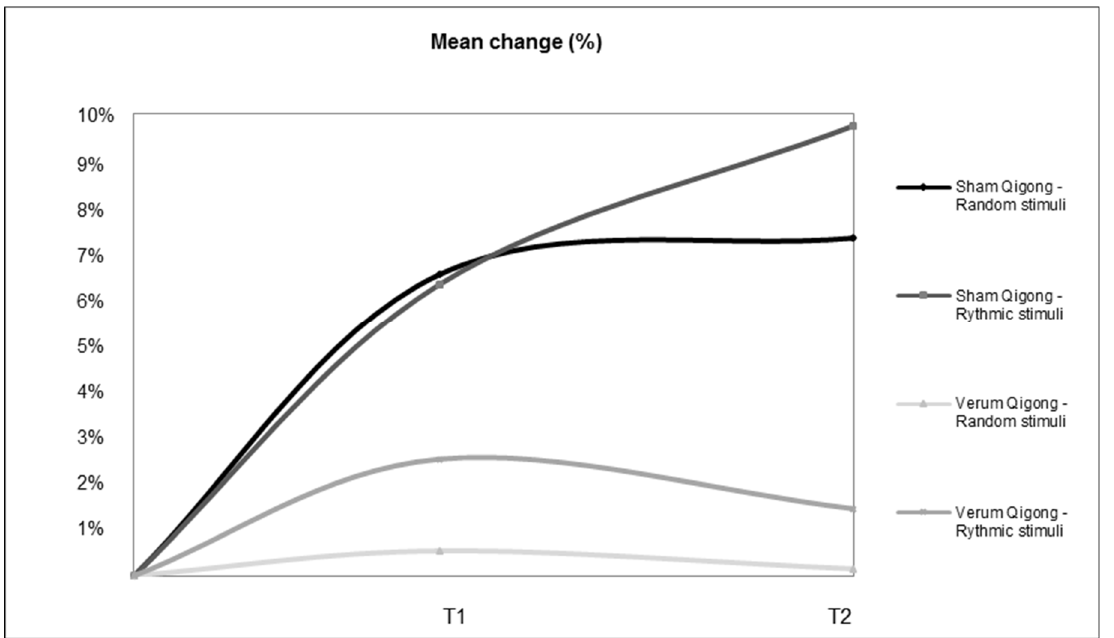
Figure 2. Mean percentage change in reaction time for both groups based on the type of stimuli.